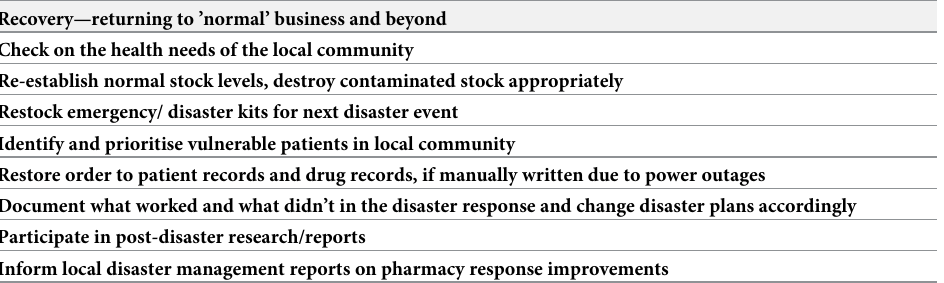
Table 5. Final Consensus on eight roles pharmacists are capable of undertaking in the recovery phase of a disaster. Recovery—returning to ’normal’ business and beyond Check on the health needs of the local community Restock emergency/ disaster kits for next disaster